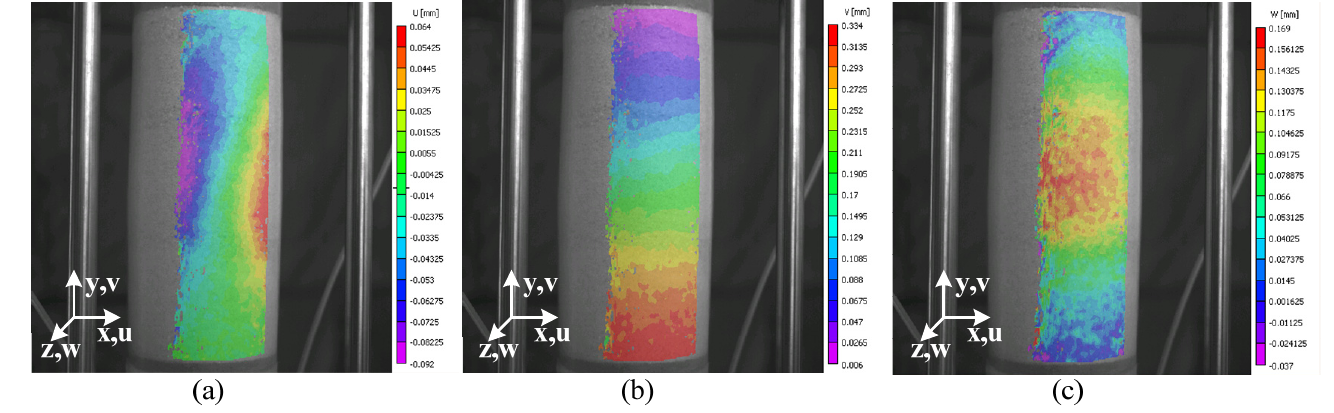
Figure 11. State of deformation of test 120904c between 2.8% and 3.0% of axial strain, obtained by the 3D ‐ DIC process: u field = horizontal ( a ), v field = vertical ( b ), and w field = out ‐ of ‐ plane ( c ). As reported in Alshibli et al. [5] and Desrues and Viggiani [26], strain localization in sand can be manifested in a wide range of phenomena, from an undeformed configuration to a deformed configuration, in which compression, expansion, and rotation over the